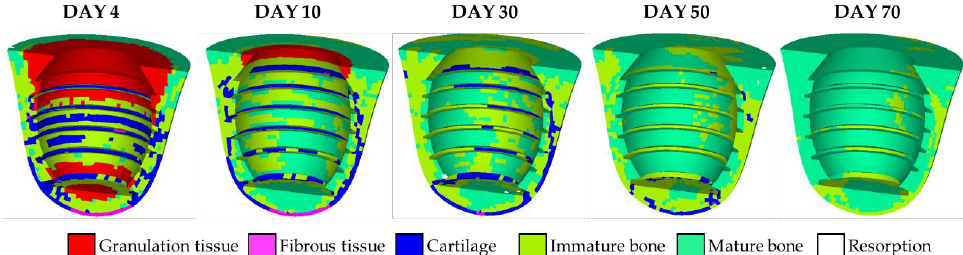
Figure 4. The tissue differentiation history predicted by the mechano-regulation algorithm.